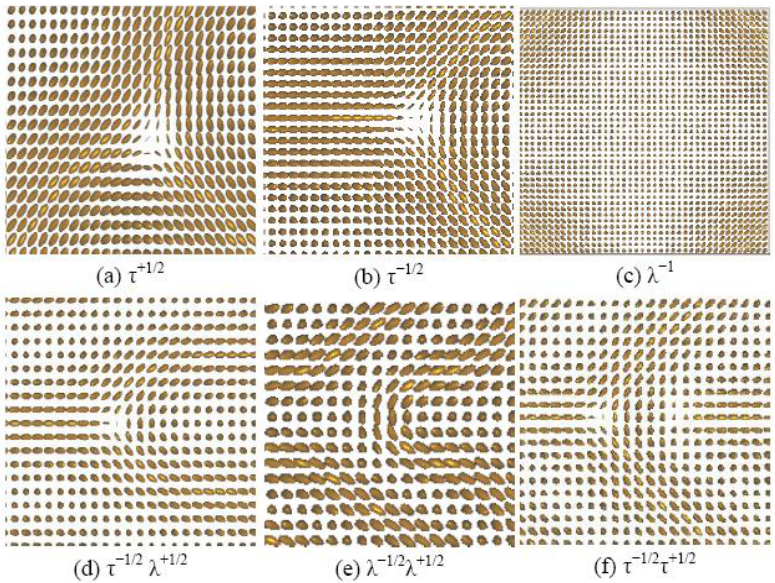
Figure 4 . The Q tensor field is visualized using the MATLAB function plotDTI developed by Barmpoutis et al. [48]. Disclination lines of τ type and splitting disclination cores into different pairs of disclinations: ( a ) τ +1/2 , ( b ) τ −1/2 , ( c ) λ −1 , ( d ) τ −1/2 λ +1/2 , ( e ) λ −1/2 λ +1/2 ( f ) τ −1/2 τ +1/2